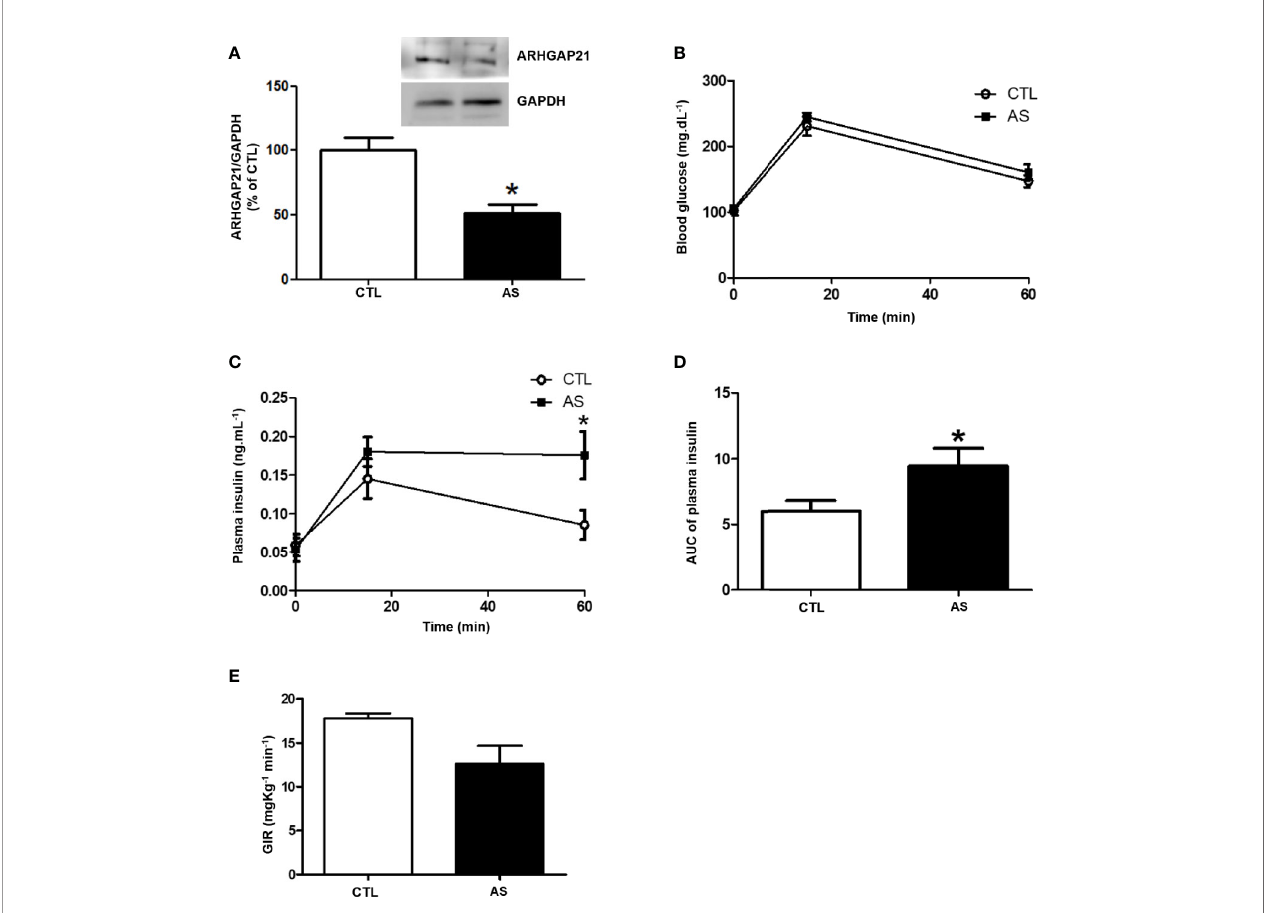
FIGURE 2 | ARHGAP21 knockdown effects on pancreatic islets ARHGAP21 expression, glucose tolerance, plasma insulin during ipGTT, and insulin sensitivity. Adult mice received intraperitoneal administrations of antisense anti-ARHGAP21 for three consecutive days, and the experiments were performed 24 h after the last administration. (A) Pancreatic islets ARHGAP21 protein expression by western blotting. (B) Blood glucose before (0 min), 15, and 60 min after an intraperitoneal administration of 1 g/Kg of glucose (ipGTT). (C) Insulin plasma before (0 min), 15, and 60 min after an intraperitoneal administration of 1 g/Kg of glucose. (D) AUC of the plasma insulin during ipGTT. (E) Hyperinsulinemic-euglycemic clamp. N = 8 – 16. Data are presented as the mean ± SEM. *P ≤ 0.05 vs CTL. CTL, control mice; AS, mice that received intraperitoneal administrations of antisense anti-ARHGAP21; ipGTT intraperitoneal glucose tolerance test; AUC, area under the curve; SEM, standard error of the